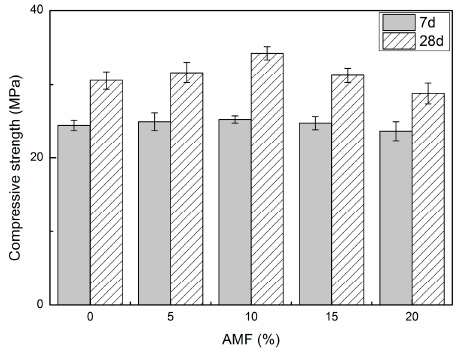
Figure 3. Effect of AMF content on the compressive strength of concrete.